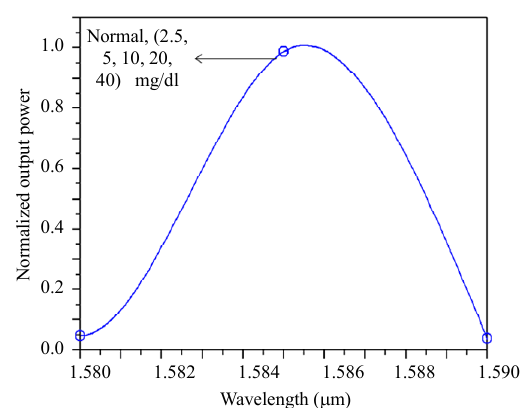
Fig. 10 Normalized output power for different bilirubin concentrations in urine. Table 5 Albumin concentration in urine and its refractive index, resonant wavelength, normalized output power, and Q factor of the proposed sensor.